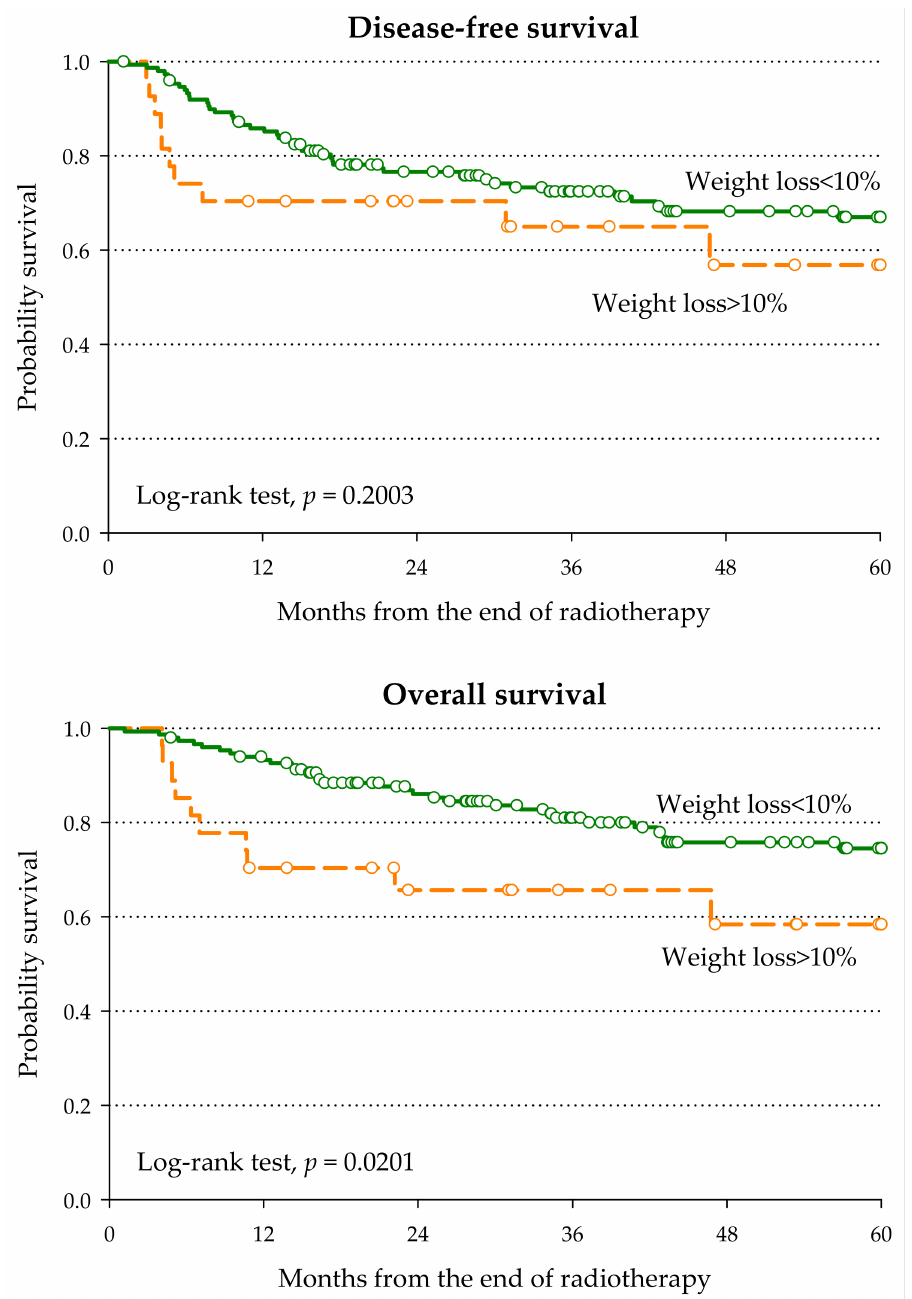
Figure 1. Disease-free survival and overall survival according to weight loss during